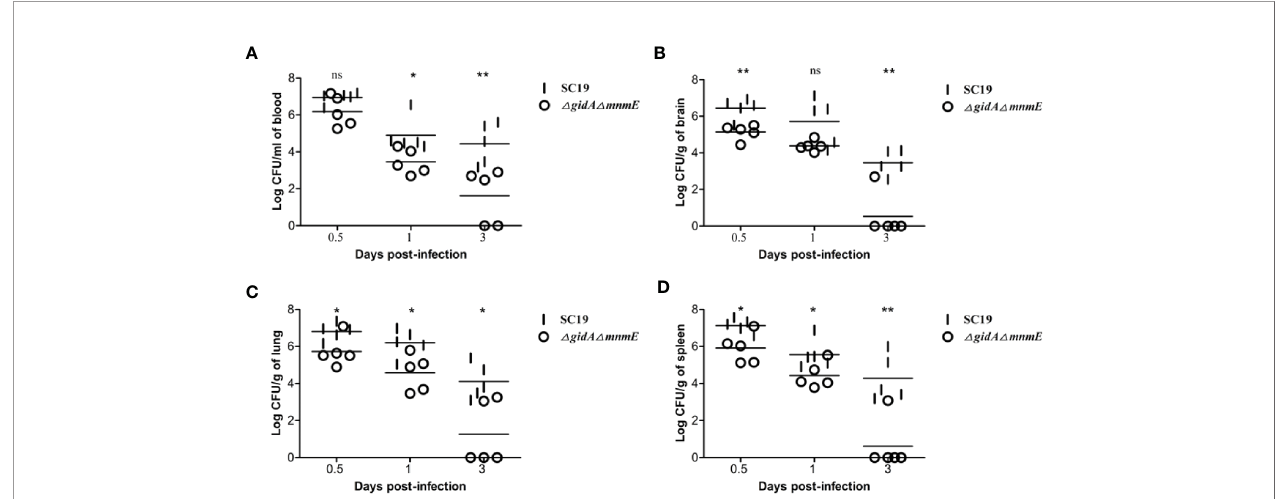
FIGURE 4 | Bacteria loads in different mouse organs. Bacteria loads (A) in blood, (B) in brain, (C) in lung, and (D) in spleen. Mice were inoculated intraperitoneally with 1 × 10 8 CFU of a 1:1 mixture of mid-log phase SC19 and D gidA D mnmE . The survival strains were enumerated by plating serial dilutions of the samples on selective plates. Data are the result of CFU/ml or CFU/g in different organs analyzed per sample ± SEM. Statistical signi fi cance was determined using the two-tailed t test (ns, p > 0.05; *, p < 0.05; **, p < 0.01; ***, p <